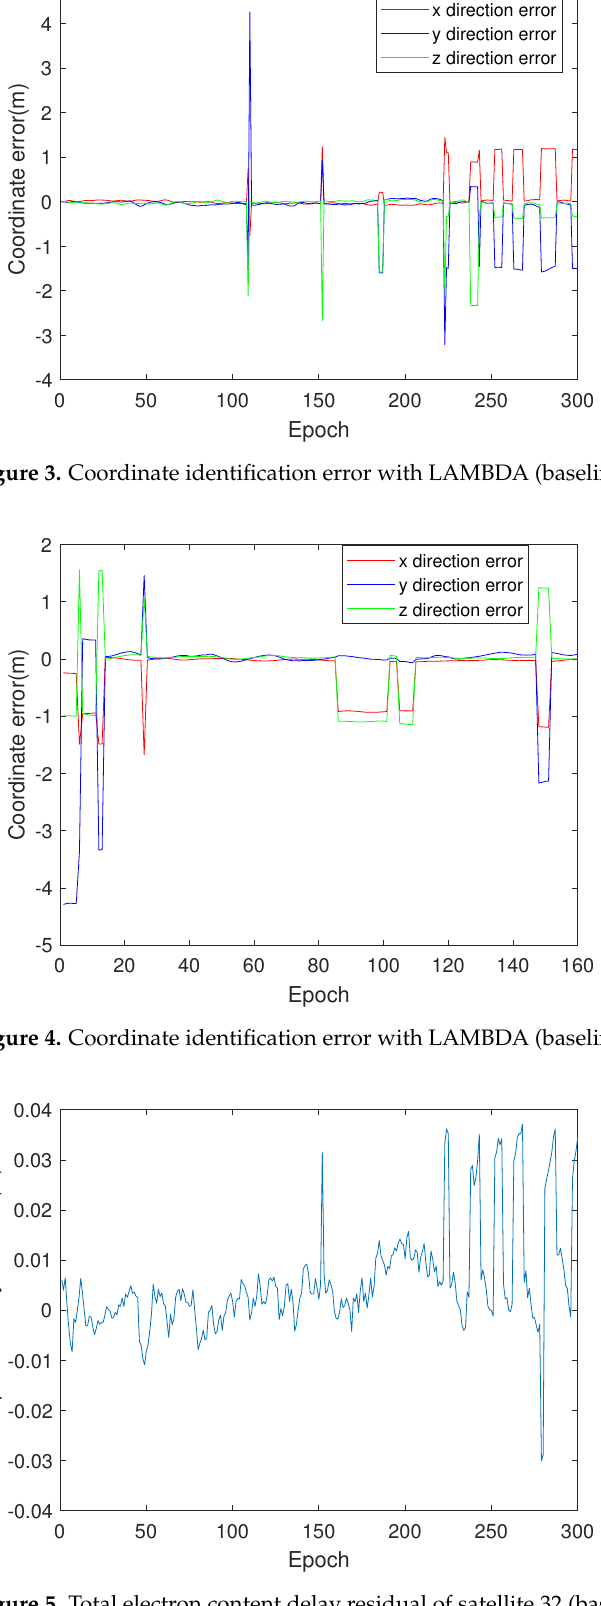
Figure 5. Total electron content delay residual of satellite 32 (baseline